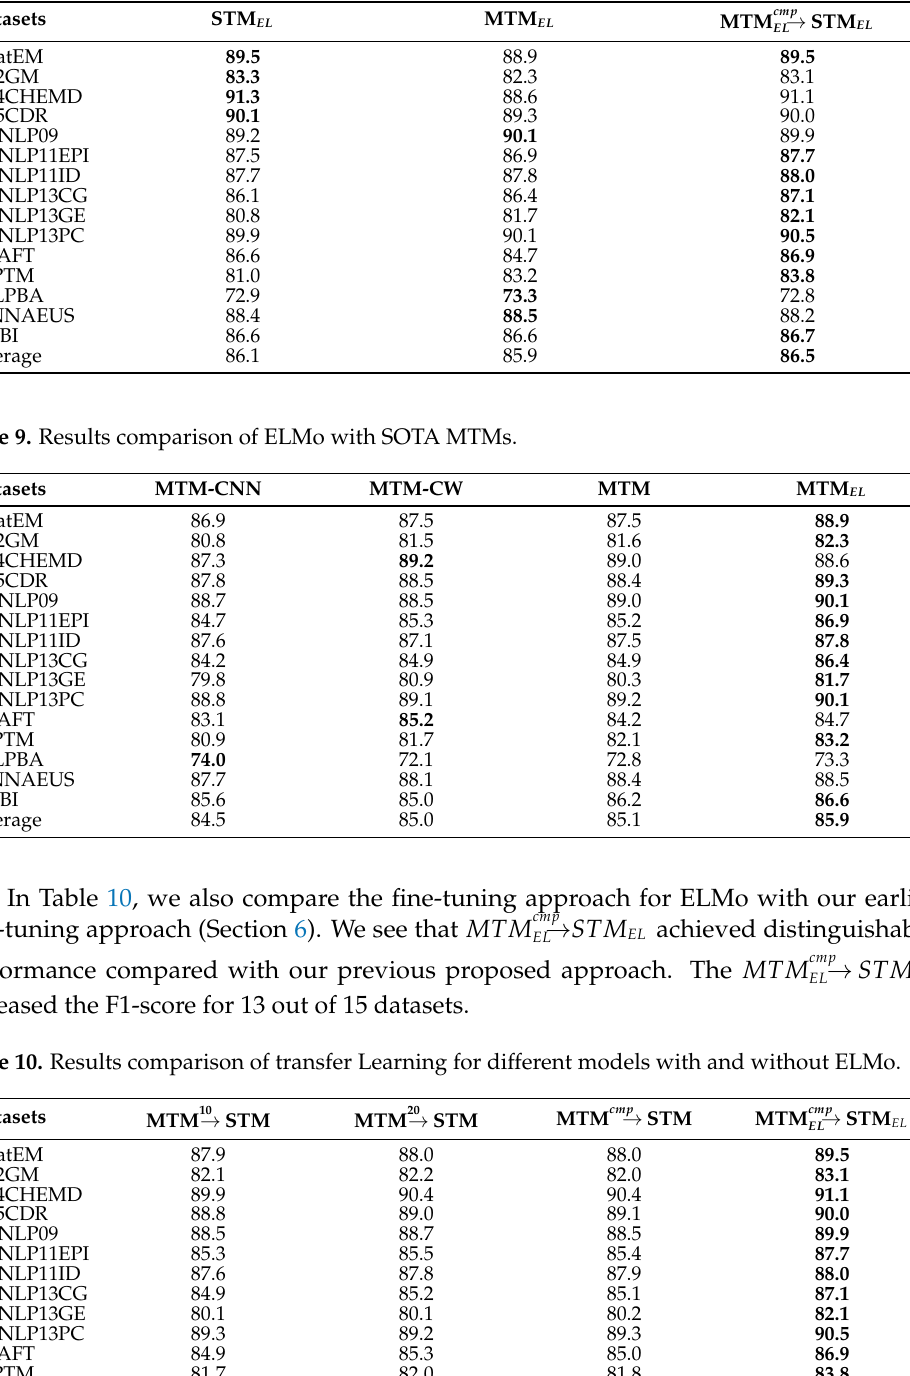
Table 8. Results comparison of different models trained on ELMo embeddings.